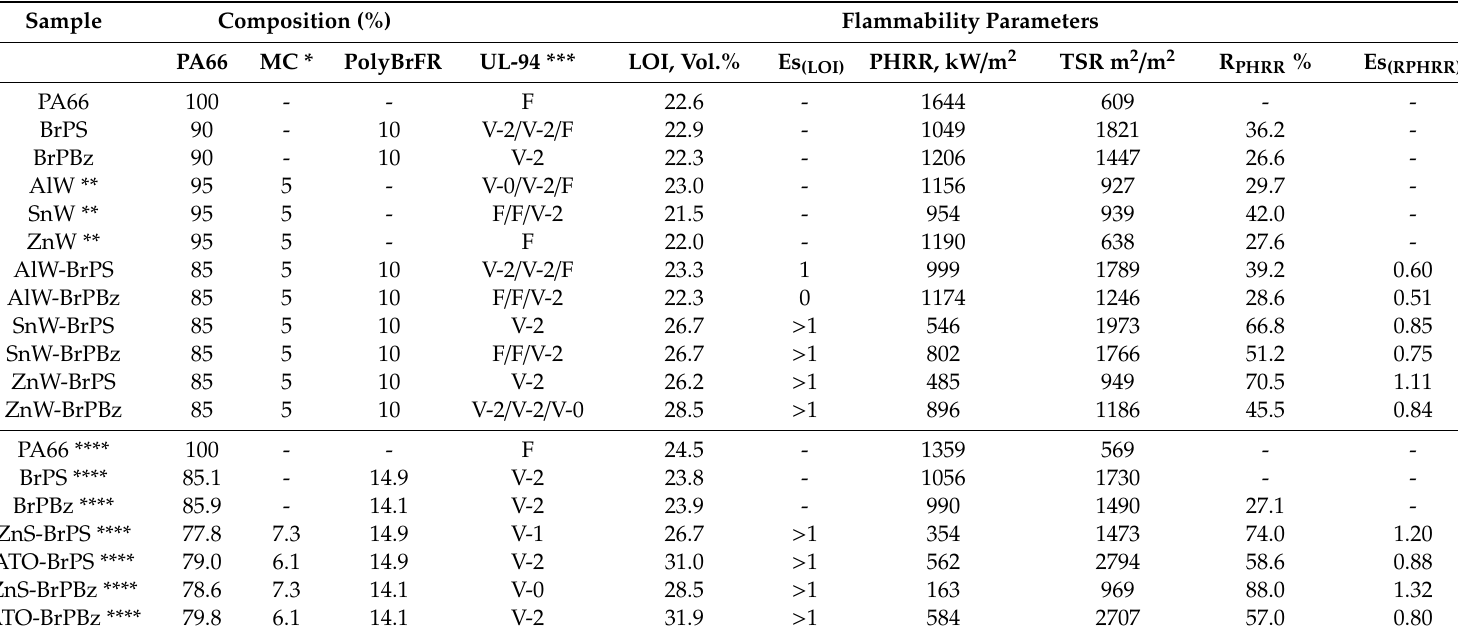
Table 2. Formulations, principal flammability parameters and derived synergistic e ff ectivities for tungstate / zinc stannate / ATO-bromine-containing formulations in